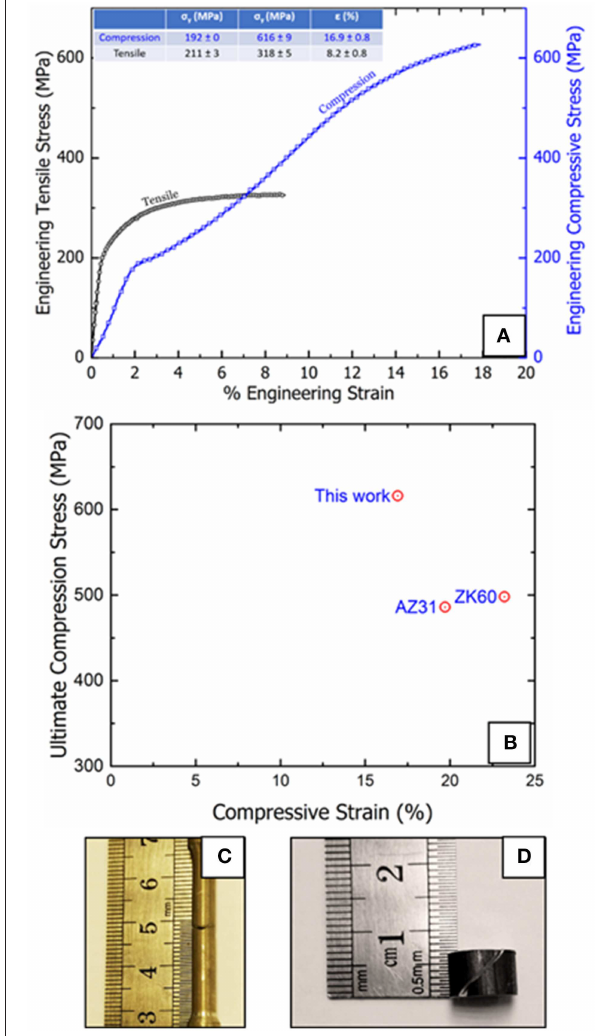
FIGURE 2 | Mechanical behavior of Mg 80 Al 5 Cu 5 Mn 5 Zn 5 alloy. (A) Engineering stress vs. strain graphs. Table (Inset) contains the engineering stress and strain values observed in compression and tension. Standard deviation results indicate the consistency and reliability of material. (B) Comparison of stress and strain with other Mg alloys reveals the superiority of Mg 80 Al 5 Cu 5 Mn 5 Zn 5 MCA. (C,D) Fractured samples during tensile and compression